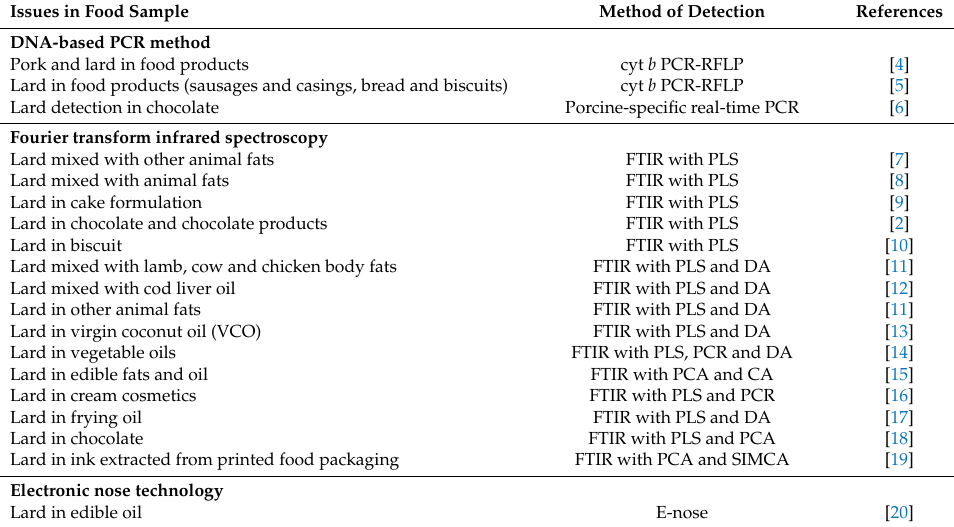
Table 1. Methods for the detection of lard in foods and food